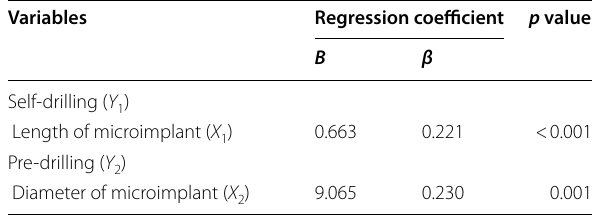
Table 7 Stepwise multiple regression analysis of the effect of associated variables on removal torque